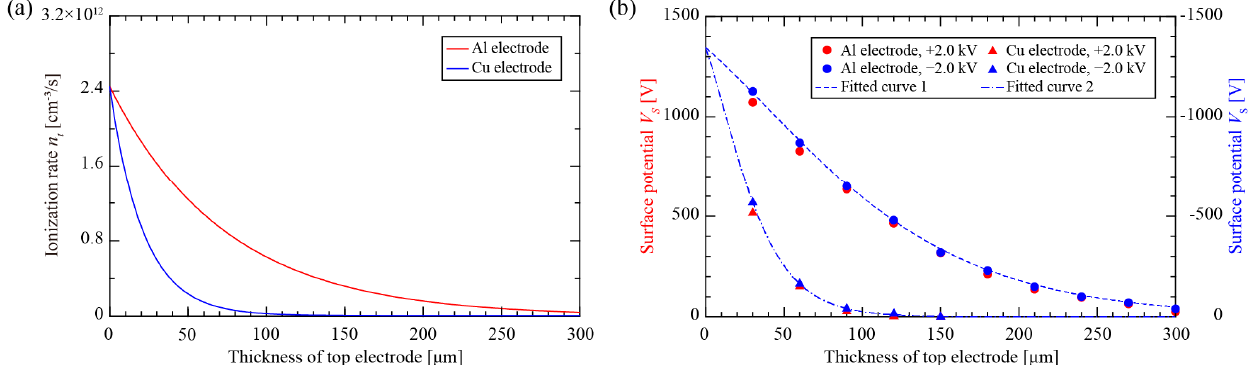
Figure 4. The metal materials influenced the soft X-ray ionization rate and the charging performance: ( a ) ionization rates beneath the electrode layer; ( b ) obtained surface potentials after a charging time of 10 s at V DC = ±2.00 kV.